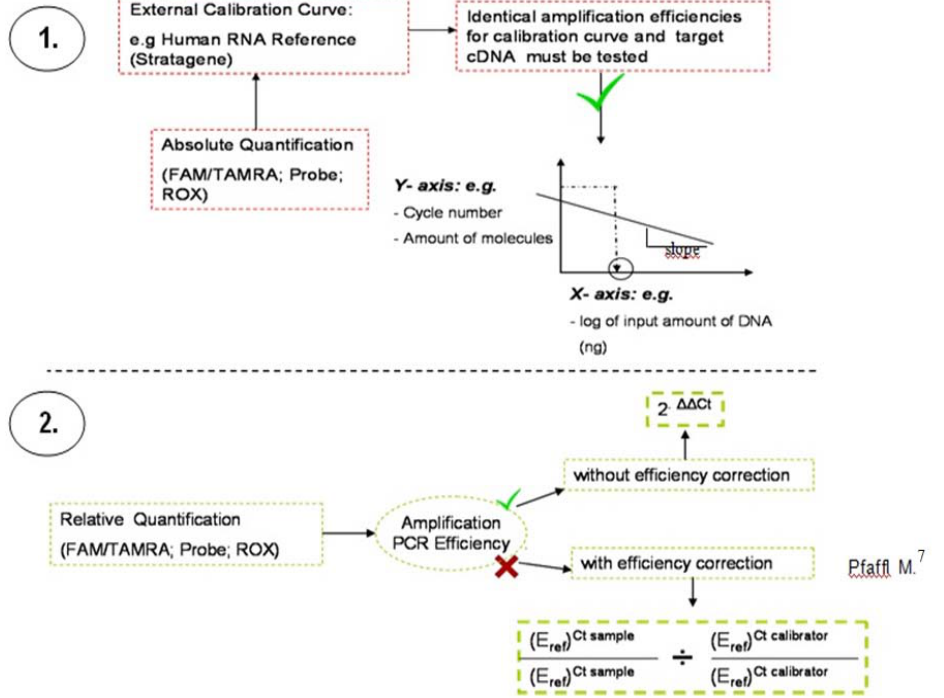
Figure 3. Methodology used to evaluate Q-PCR data. The absolute quantification (1.) relates the PCR signal (cycle number) to the input amount of DNA, using a calibration curve. By use of regression line analysis the amplification efficiency of the whole